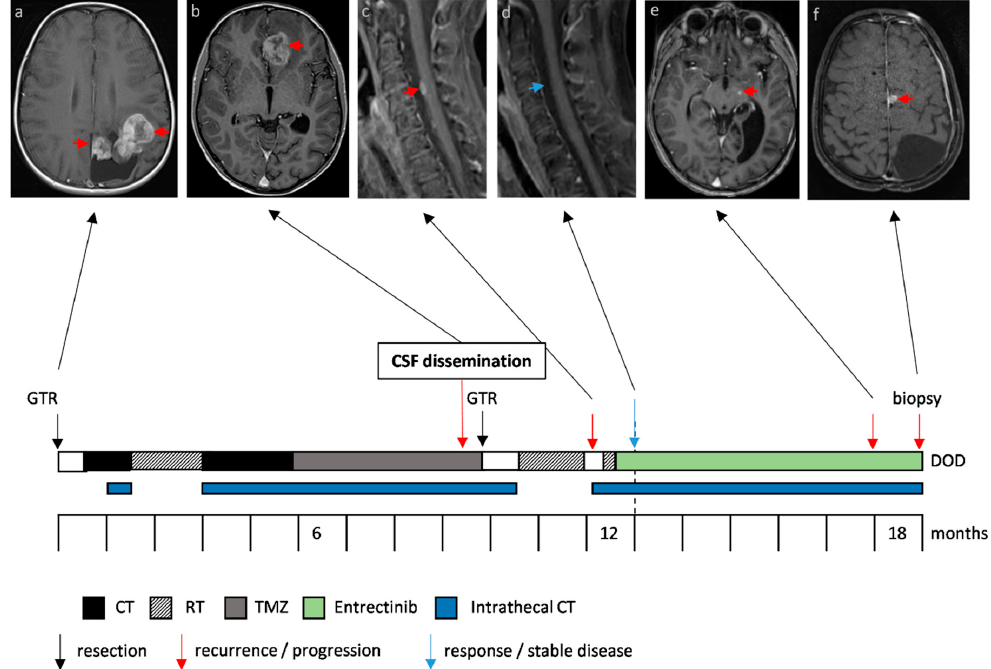
Figure 2. Case 2, a gliosarcoma harboring an EML4:NTRK3 fusion. Therapy response and progression of metastases under treatment with entrectinib is depicted in axial T1 weighted contrast-enhanced magnetic resonance images of the brain and sagittal images of the cervical spine. The red arrows indicate the primary tumor ( a ) and metastases ( b , c , e , f ), the blue arrow the regression of the perimedullary metastasis ( d ). The timeline indicates the different treatment strategies and interventions. Table 1. Histopathologic, molecular characteristics and next-generation